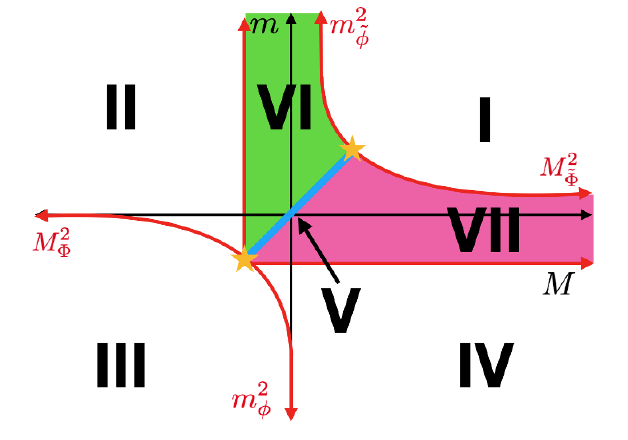
Figure 3 . Phase diagram for (cid:13)avor broken QCD 3 with f; F < k . The phases are described in section 2.2.1. The stars denote the bosonic duals given in